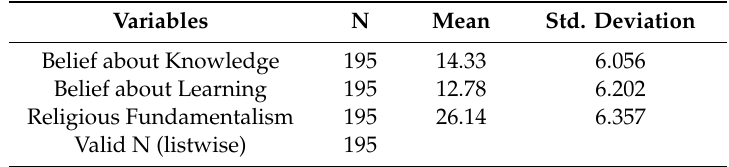
Table 1. Descriptive